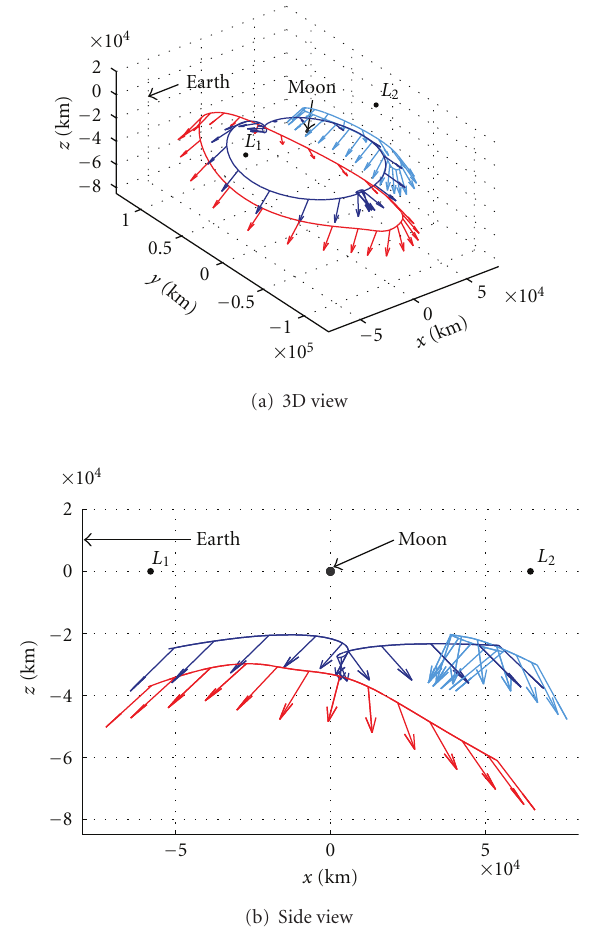
interpolating with neighboring points in the periodic